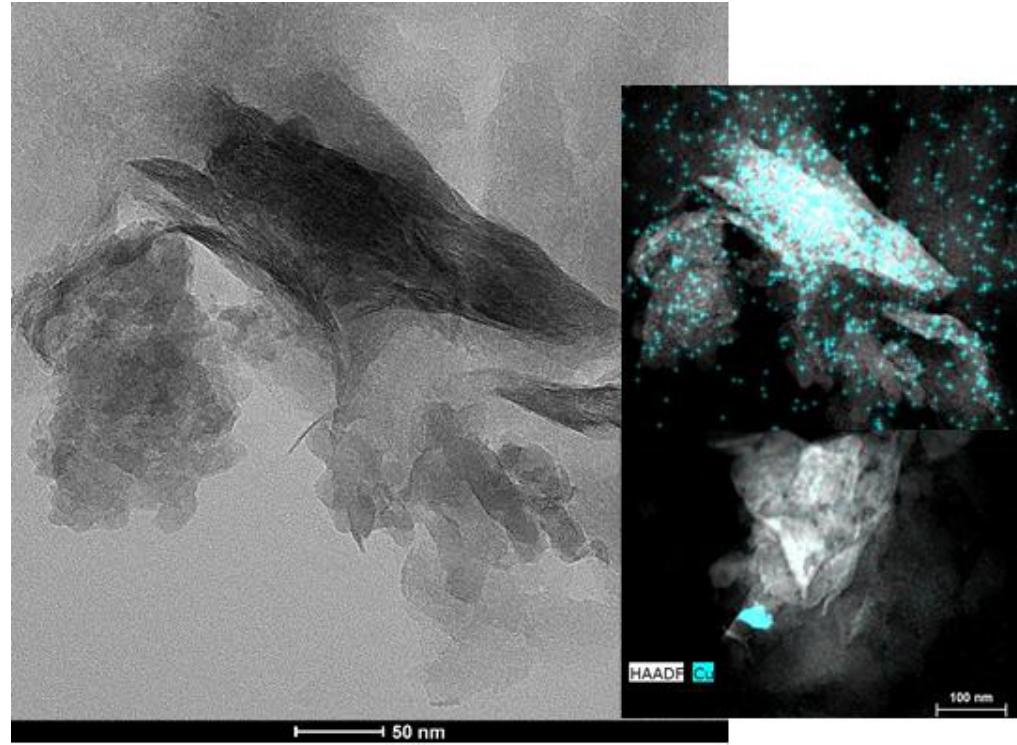
Figure 4. TEM micrograph of Cu-volcanic glass.